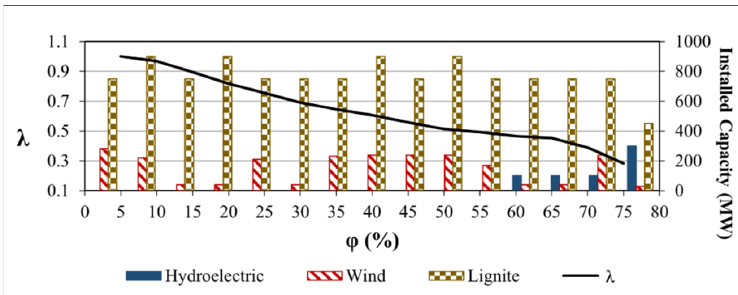
Figure 9. The relationship between φ , λ , and investments.